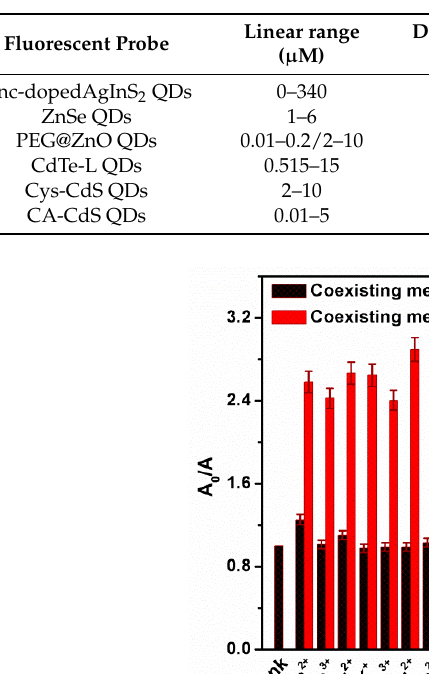
Figure 10. ( a ) Fluorescence spectra of CA-CdS QDs upon the addition of various concentrations of Cu 2+ , ( b ) the change between the relative fluorescence area (A 0 /A) of the CdS QDs and different levels of Cu 2+ , the calibration curve of Cu 2+ detection in the range of 0–5 μ M ( c ) and 7–50 μ M ( d ). Table 2. Comparison of different fluorescence sensor in Cu 2+ sensing performances.